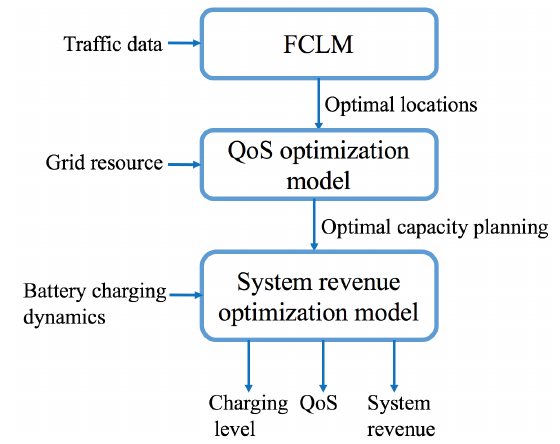
Figure 1. System